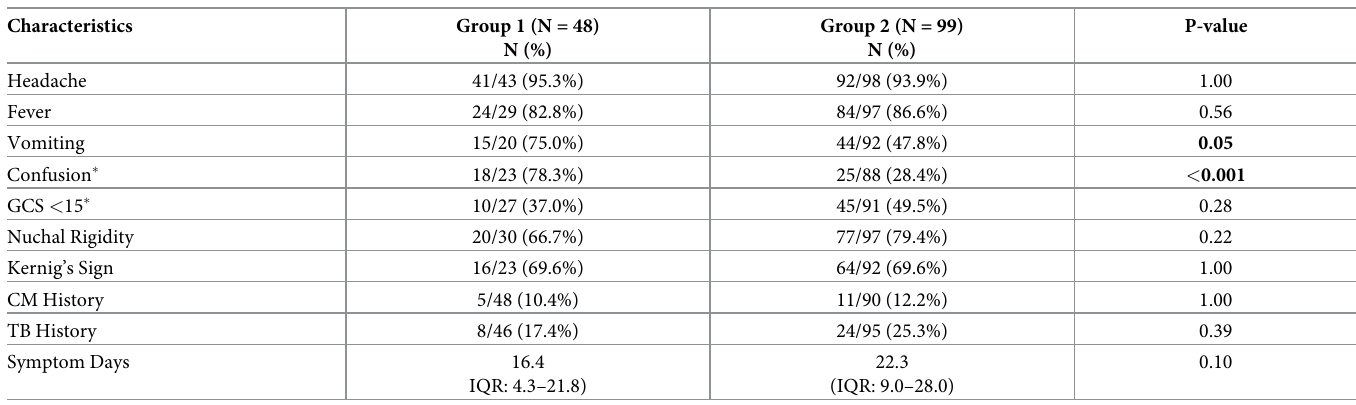
Table 2. Baseline symptoms at admission among CM confirmed. Characteristics